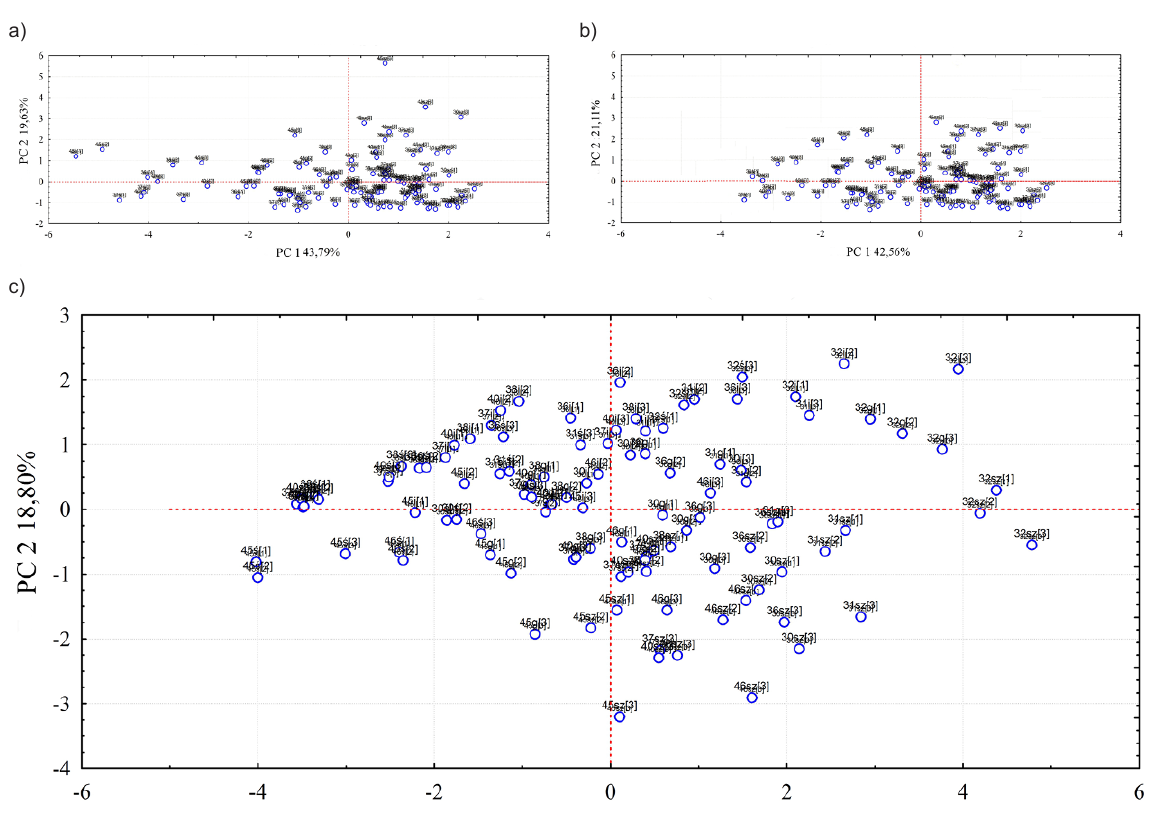
Figure 1. Projection of the analysed data on the first plane defined by two main principal components: a) the raw data, b) data after SNV transformation, c) projection of analysed data on the plane defined by the first two principal components and subject to the Box-Cox transformation.